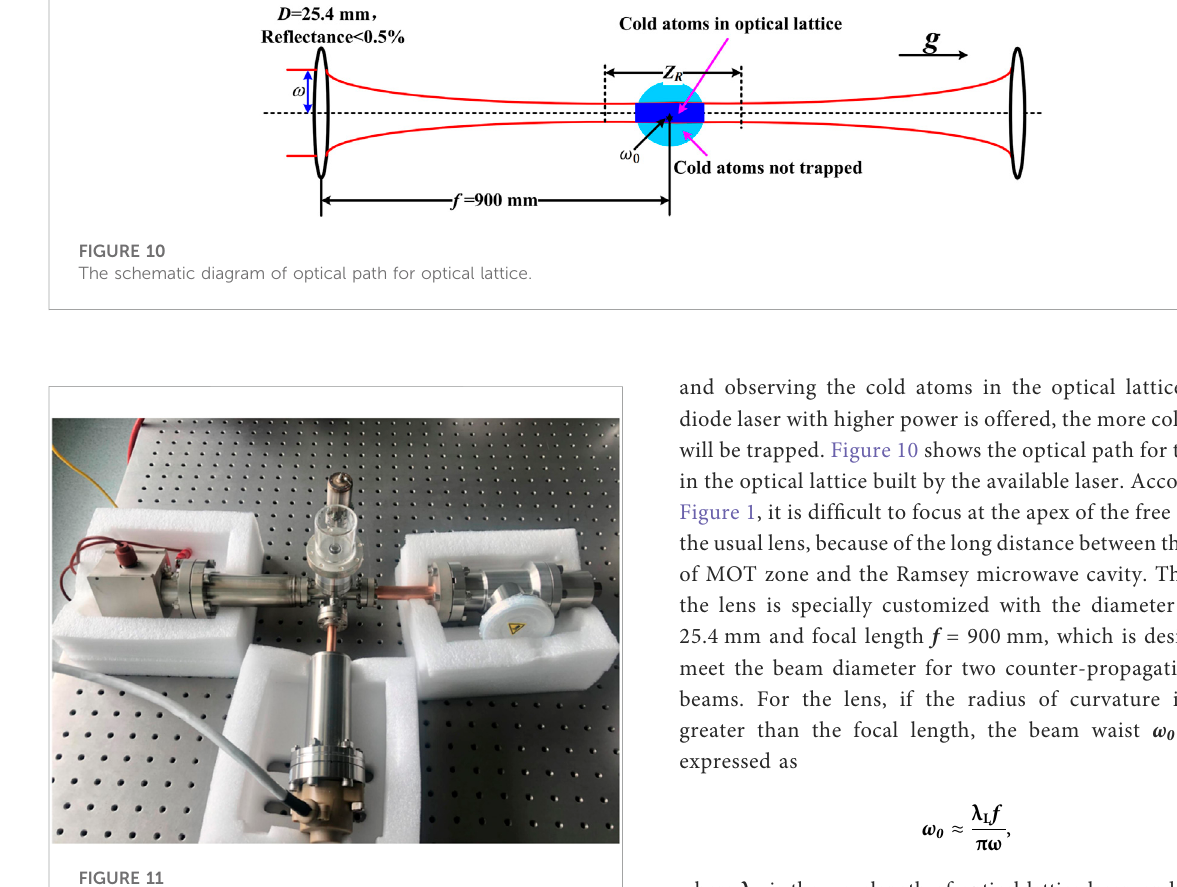
FIGURE 11 The miniaturized vacuum